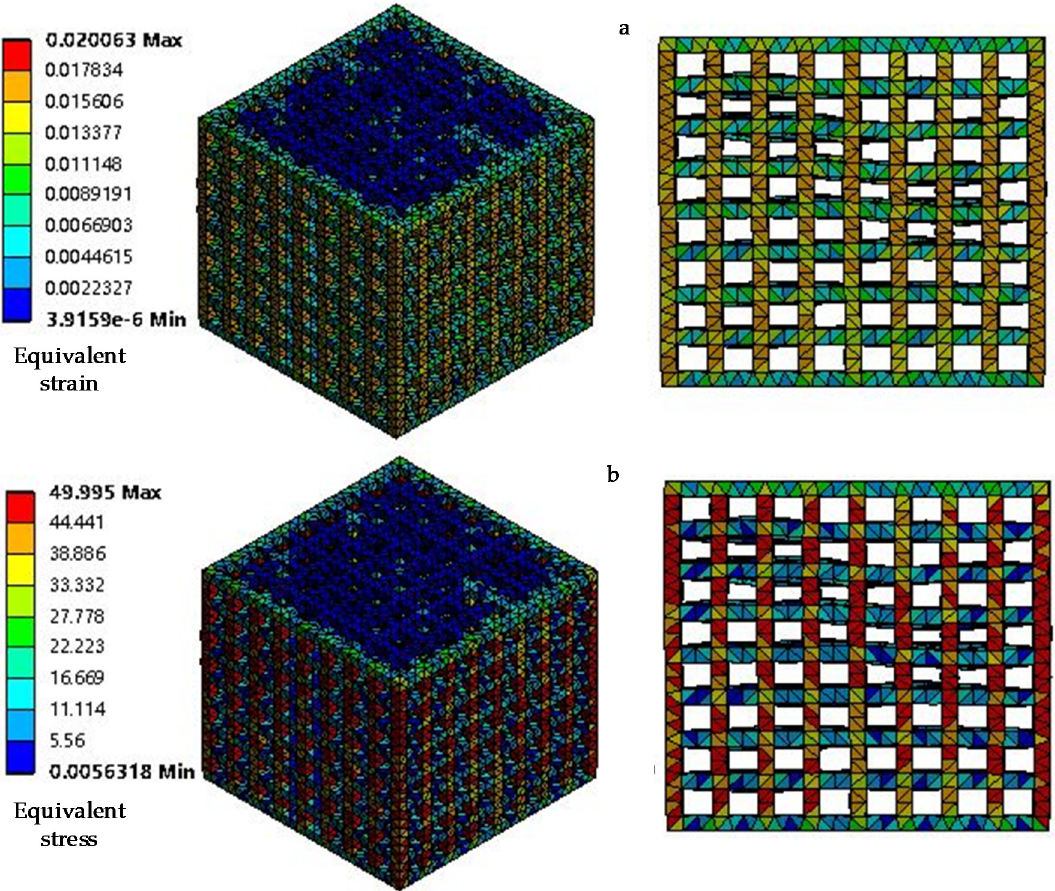
Figure 5. The distribution of equivalent stress and equivalent strain for model 3 with 256 pillars removed. ( a ) equivalent strain distribution; ( b ) equivalent stress distribution.